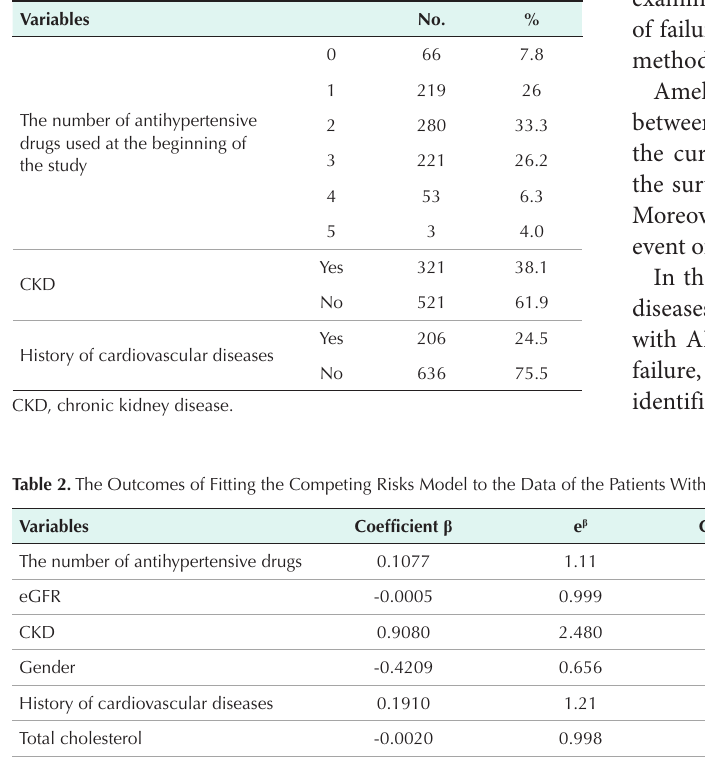
Table 1. Frequency and Percentage of the Studied Patients, Based on Each Variable Variables No. %